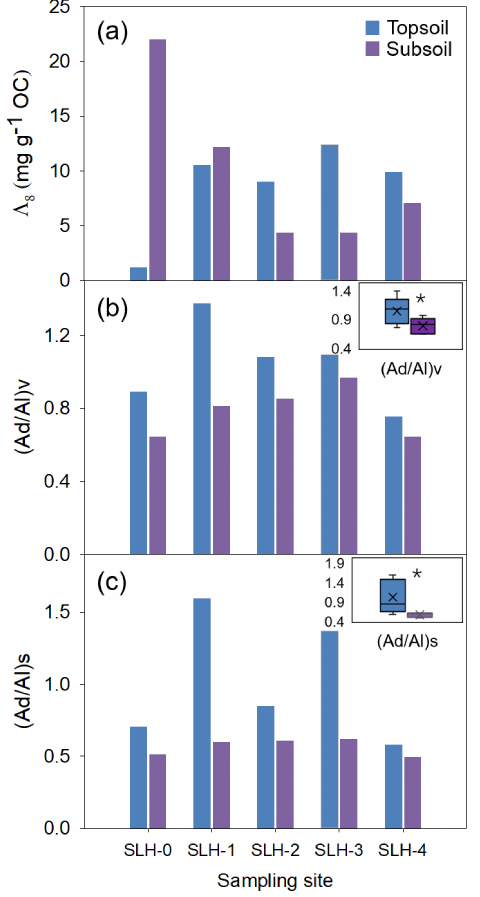
Figure 4. Concentration of lignin phenols normalized by organic carbon (OC) ( (cid:51) 8 , a ). The acid-to-aldehyde (Ad / Al) ratios of vanil- lyl (V, b ) and syringyl (S, c ) phenols in the soil of the Shaliu River basin. The solid bar and cross in the inserted boxes in panels (b) and (c) mark the median and mean of each dataset, respectively. The upper and lower ends of boxes denote percentiles 0.25 and 0.75, respectively. Asterisks indicate significant differences between top- soil (0–10cm) and subsoil (40–60cm; paired-sample t tests, n = 5, p < 0.05). The legends in panel (a) also apply to other panels.